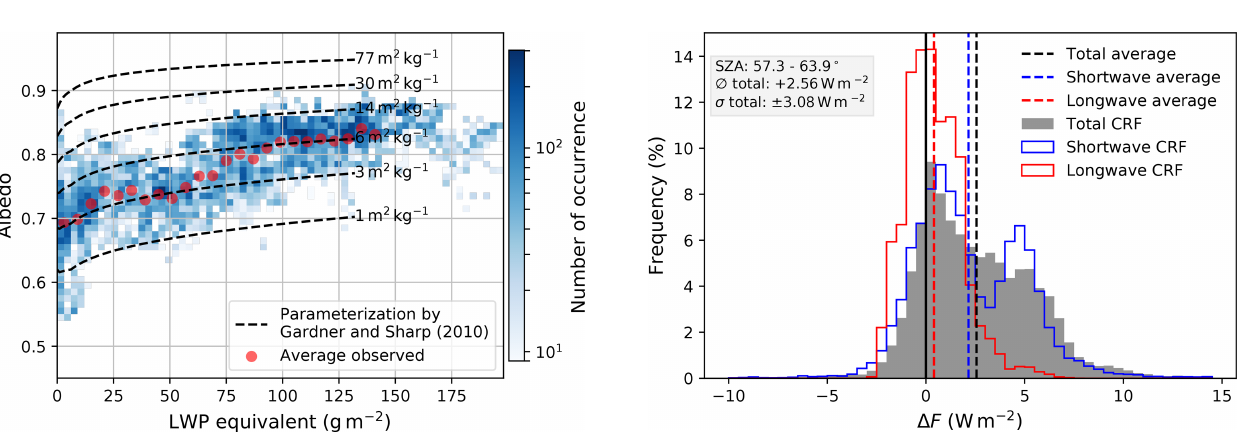
Figure 8. Relation between broadband albedo and retrieved LWP equivalent observed on 14 June 2017 ACLOUD flight over homo- geneous sea ice ( I f > 98%). The broadband albedo parameteriza- tion by Gardner and Sharp (2010) is shown for different SSA and the average SZA by the dashed lines (impurity load of 0.1ppmw). Averaged observations (6gm − 2 bins) are shown by red scattered points.